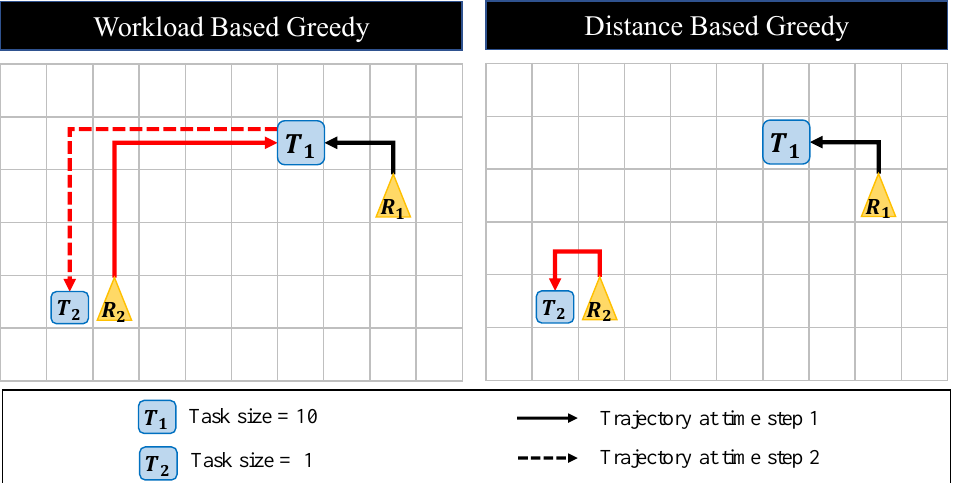
Figure 5. Two types of greedy algorithm on an example problem. In workload based greedy, the robot chooses the task T 1 whose workload is larger than the workload of T 2 . In this case, the makespan = 3 + ( 3 + 6/2 ) + 9 = 18, while the makespan of the distance based greedy is ( 10 + 1 ) = 11. In this example, the travel time of R 2 at time step 1 is redundant in the workload based